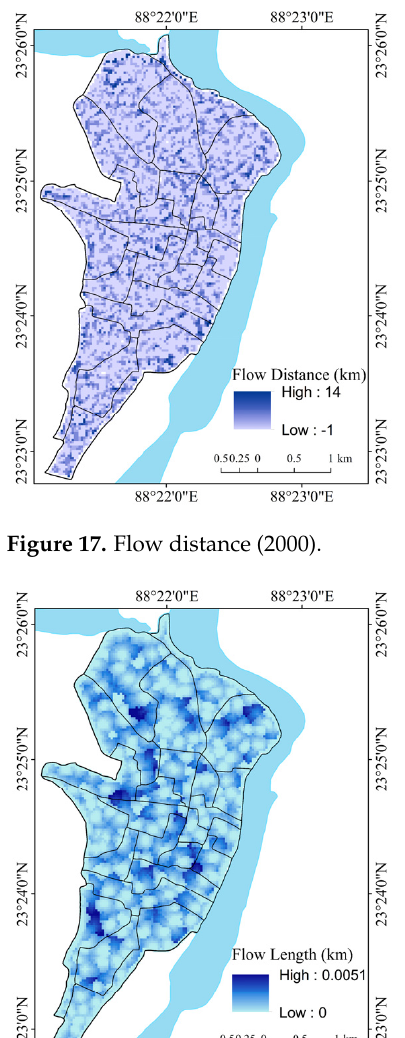
Figure 16. Flow direction (2000).